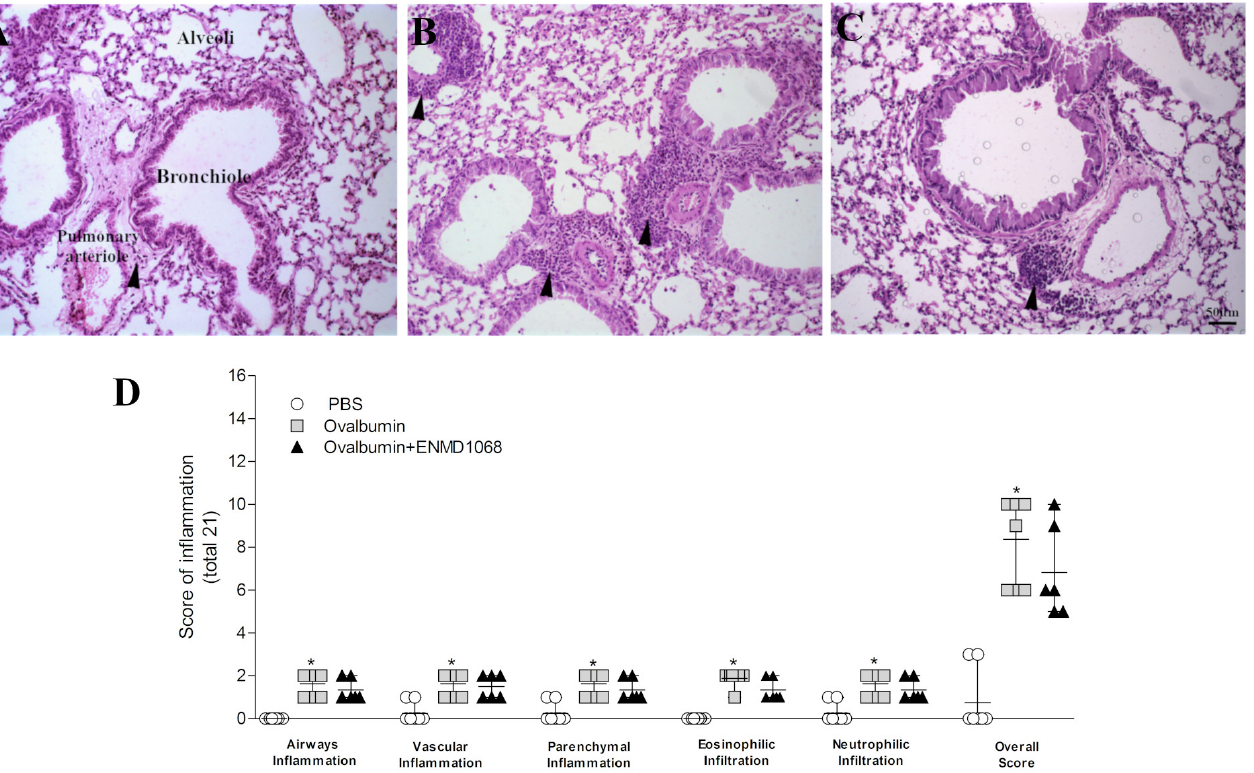
FIGURE 2 - Effects of PAR2 peptide antagonist ENMD1068 treatment on the histological changes in the lungs of sensitized mice by multiple exposures to OVA. Representative histological sections of lungs of mice 48 hours after the last intranasal allergen challenge and stained by hematoxylin and eosin. The black point arrows indicate inflammatory cell infiltration around bronchioles and vessels in ovalbumin-sensitized mice instilled with PBS (A), OVA (B) or pretreated with ENMD1068 1 h before intranasal instillation of OVA (C). Histopathological score of inflammation (D). The results are representative of 2 independent experiments and are expressed as the mean ± SEM of 6-8 mice/group. * p<0.05 compared to the PBS group (Kruskal-Wallis test followed by Dunn’s multiple comparison